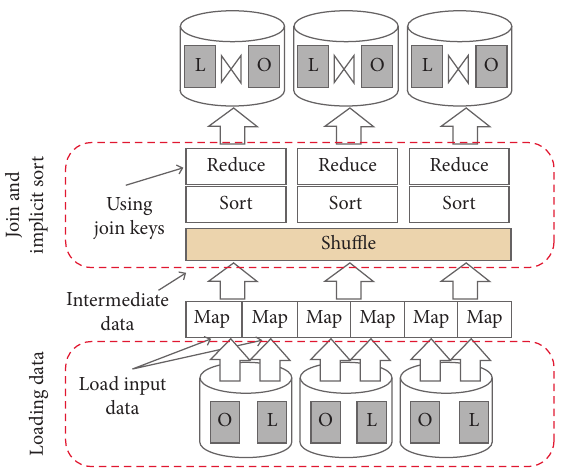
Figure 1: MapReduce join query